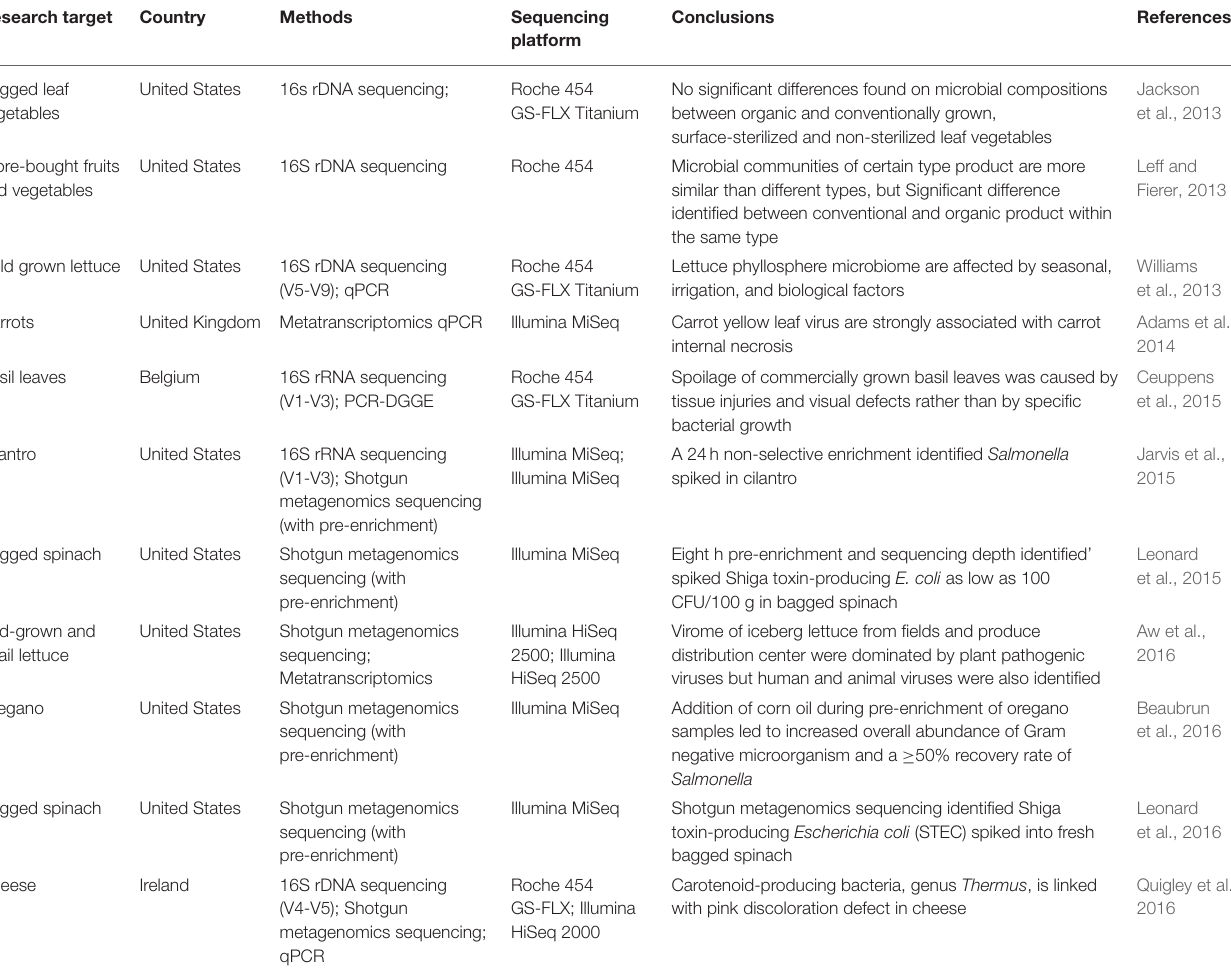
TABLE 3 | A comprehensive list of publications using next generations sequencing approaches in characterizing the microbiome of ready to eat